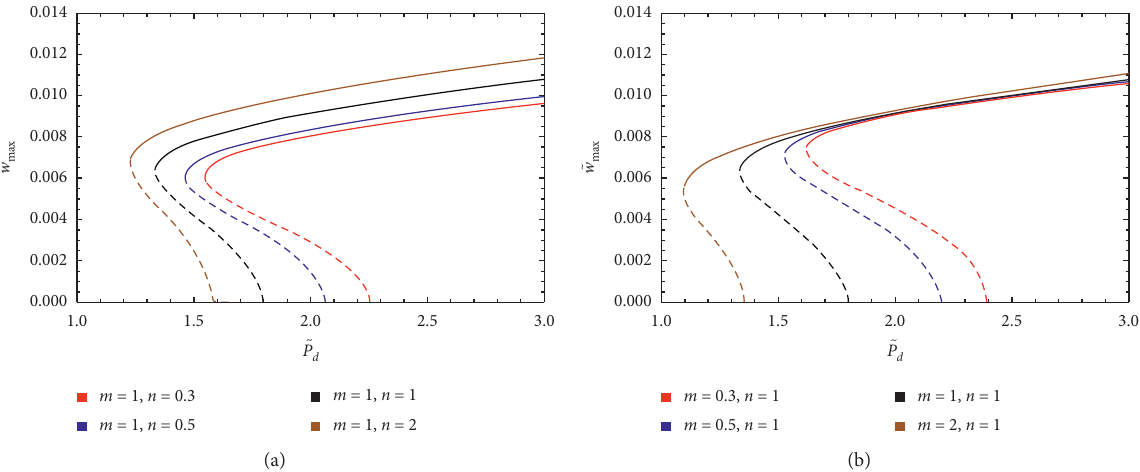
Figure 12: Effect of gradient parameters on the force-response curves of type I BDFG beam with L / h � 20, 􏽥 c 􏽥 Ω � 1 . 02 × 2 􏽥 ω l